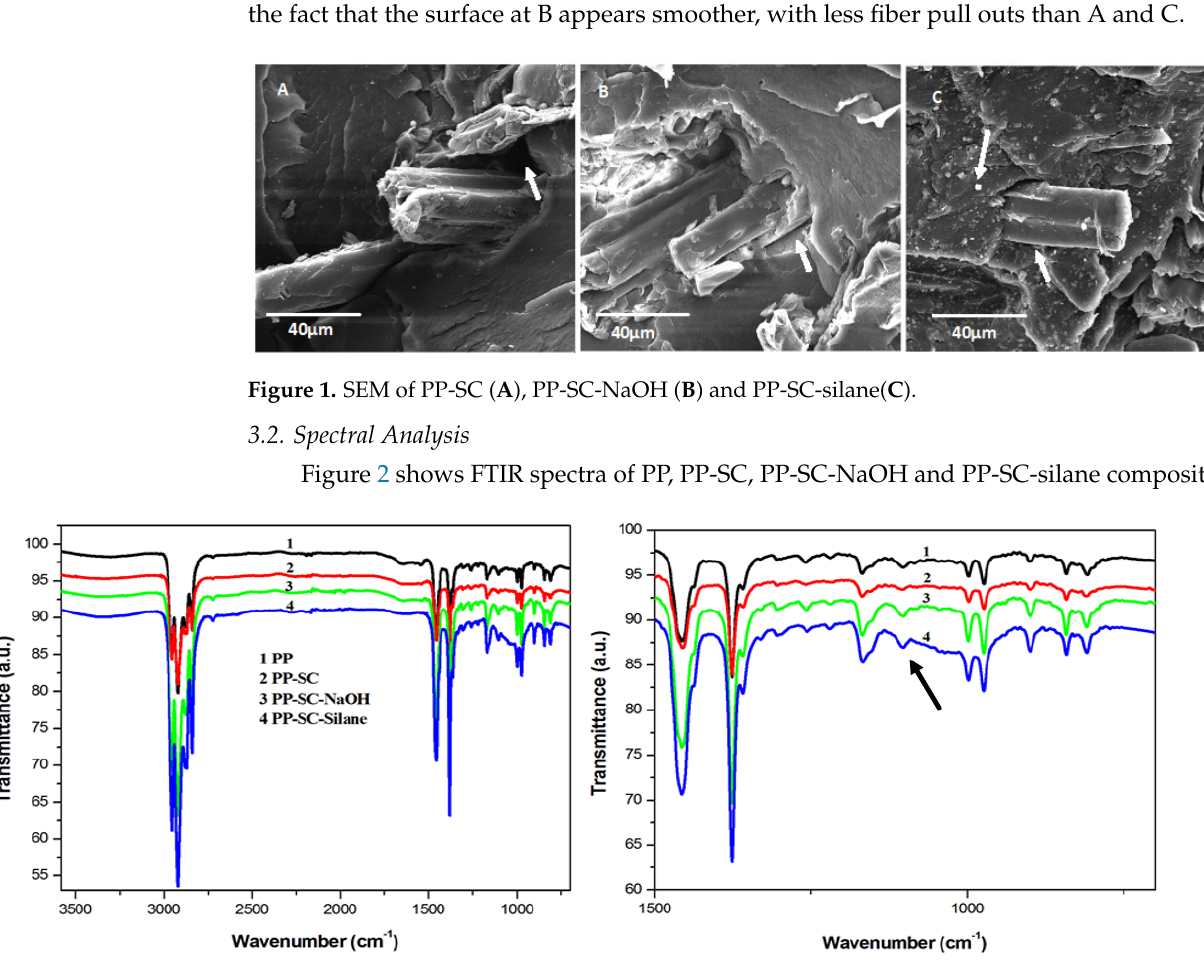
Figure 2. FTIR spectra of PP,PP-SC,PP-SC-NaOH and PP-SC-silane. As expected, all the spectra displayed typical peaks of PP [20]. For example, large four peaks in wavenumber range 3000–2800 cm − 1 represent CH 3 asymmetric, CH 3 symmetric stretching, CH 2 asymmetric and symmetric stretching vibrations, respectively, although C-C asymmetric stretching, C-H wagging and CH 3 asymmetric deformation vibrations were displayed at 1102, 1222 and 1258 cm − 1 .